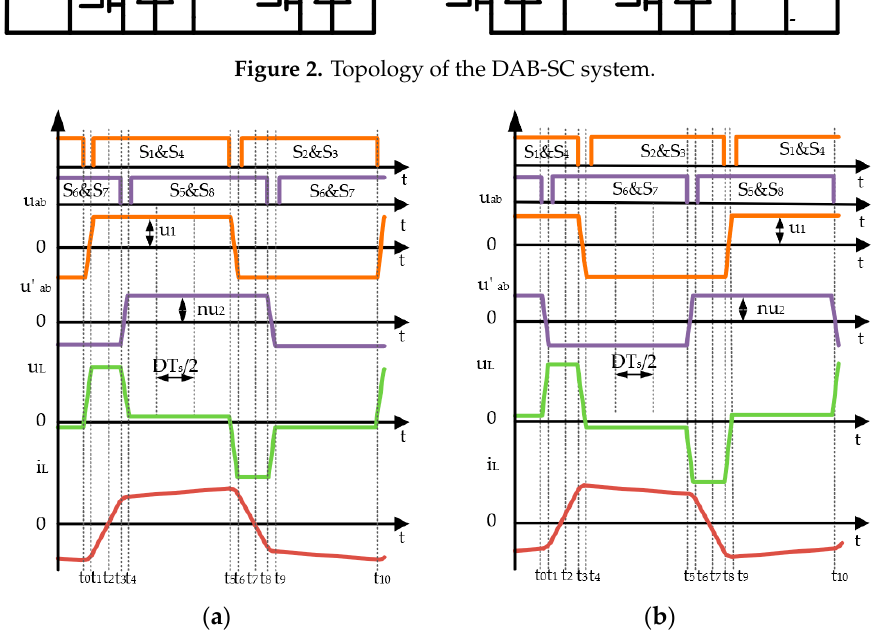
Figure 3. The main working waveform of the DAB converter with phase shift control: ( a ) Forward power transfer; ( b ) reverse power transfer.